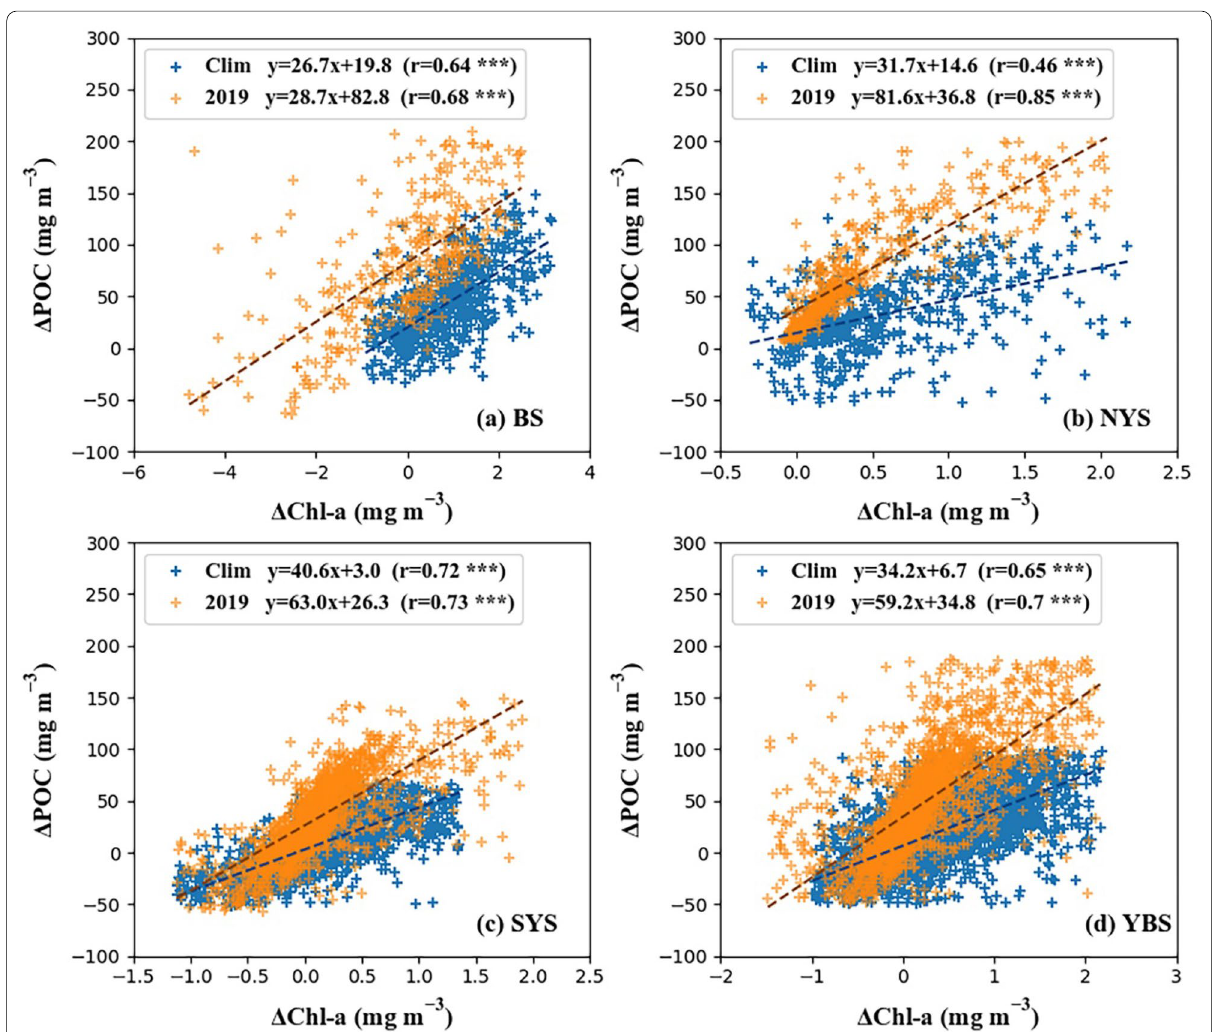
Fig. 7 Correlation analyses for the changes of POC (ΔPOC) and chlorophyll‑a (ΔChl‑a) from 1–8th to 14–21st August for non‑typhoon years and 2019 in the Bohai Sea (BS), north Yellow Sea (NYS), south Yellow Sea (SYS), and Yellow‑Bohai Sea